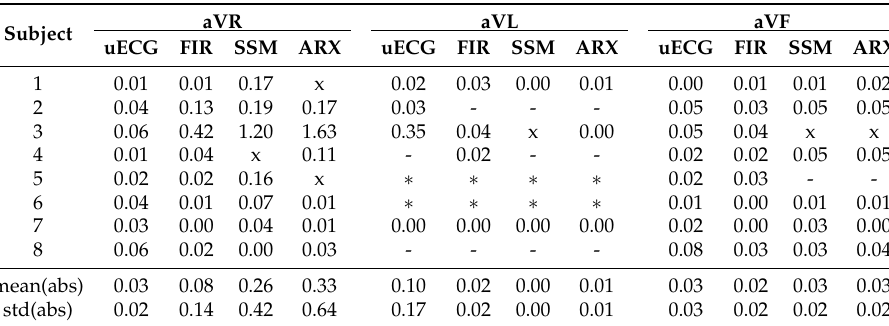
Table A4. Mean squared error for the amplitude deviation of the T